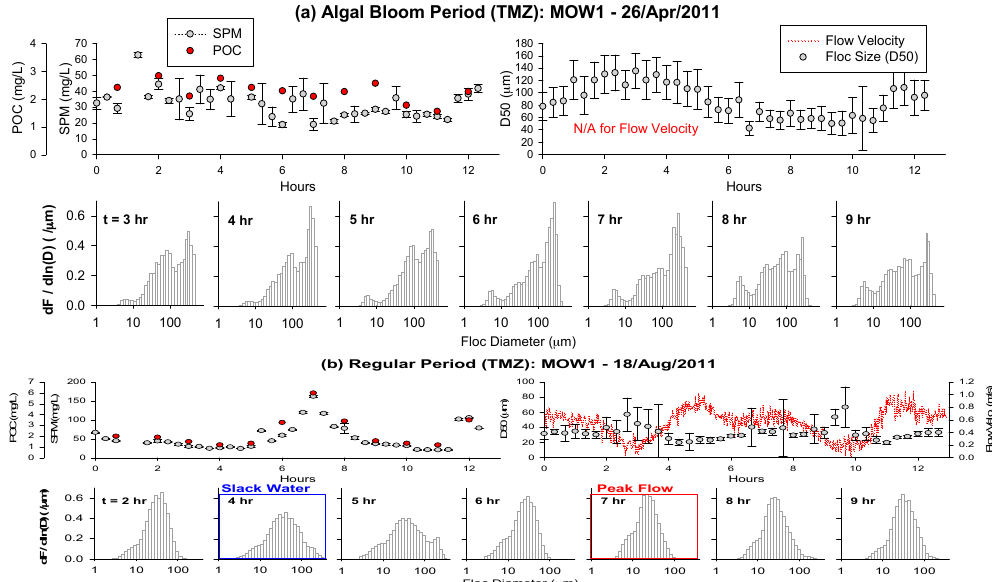
Figure 7. Dynamic behaviors of suspended particulate matter (SPM) and particulate organic carbon (POC) concentrations, aggregate size (D50), and particle size distribution (PSD) in a 13-h tidal cycle. The two data sets were collected in the TMZ (i.e., the MOW1 site) on different dates in 2011, representing ( a ) algal bloom period and ( b ) regular periods.